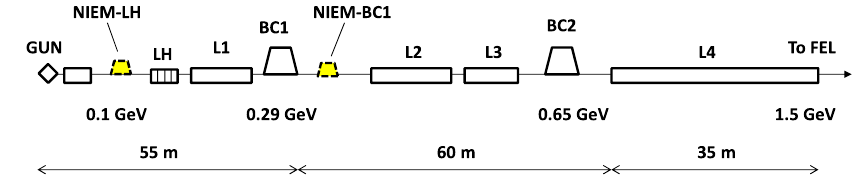
FIG. 5. Sketch of the FERMI beam accelerator complex (not to scale). Possible locations for the NIEM minichicane are shown in the laser heater (LH) and first magnetic compressor